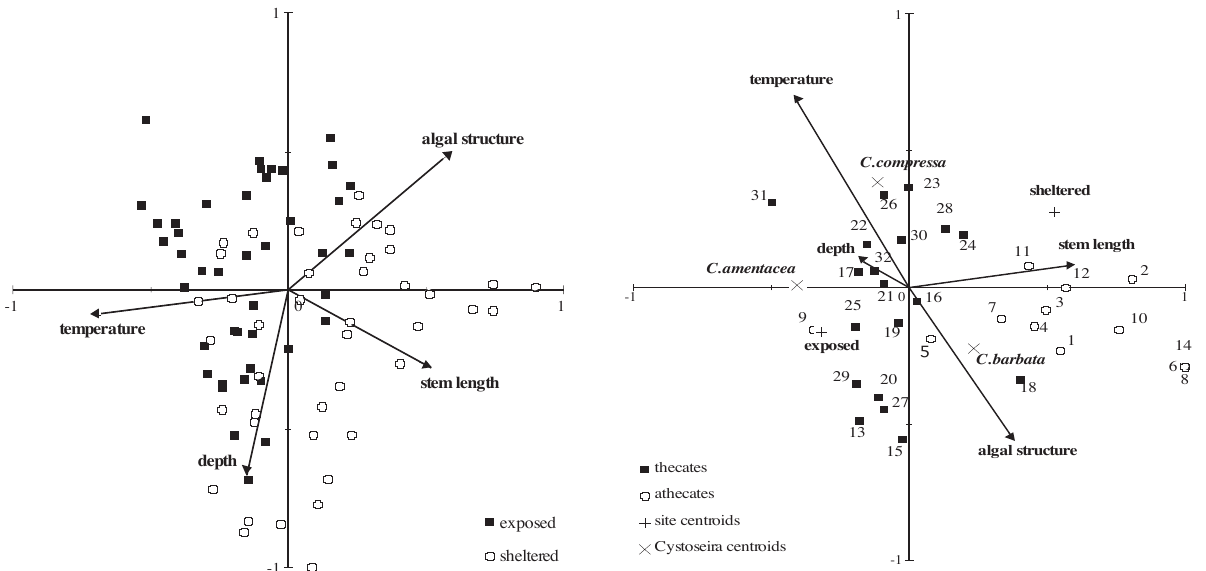
F IG . 3. – Ordination of faunal samples for exposed and sheltered F IG . 5. – Ordination of hydroid species for athecates and thecates sites using Analysis of Canonical Correspondence with environ- using Analysis of Canonical Correspondence with environmental mental variables. x and y are the first two CCA axes. Arrows show variables. x and y are the first two CCA axes. Arrows show direc- direction and rates of variation among sites in water temperature, tion and rates of variation among samples in water temperature, water depth, algal stem length and degree of algal structure water depth, algal stem length and degree of algal structure. The (P = 0.001). sheltered and exposed sites, and the three species of Cystoseira are shown by their centroids. Numbers indicate the hydroid species (P =